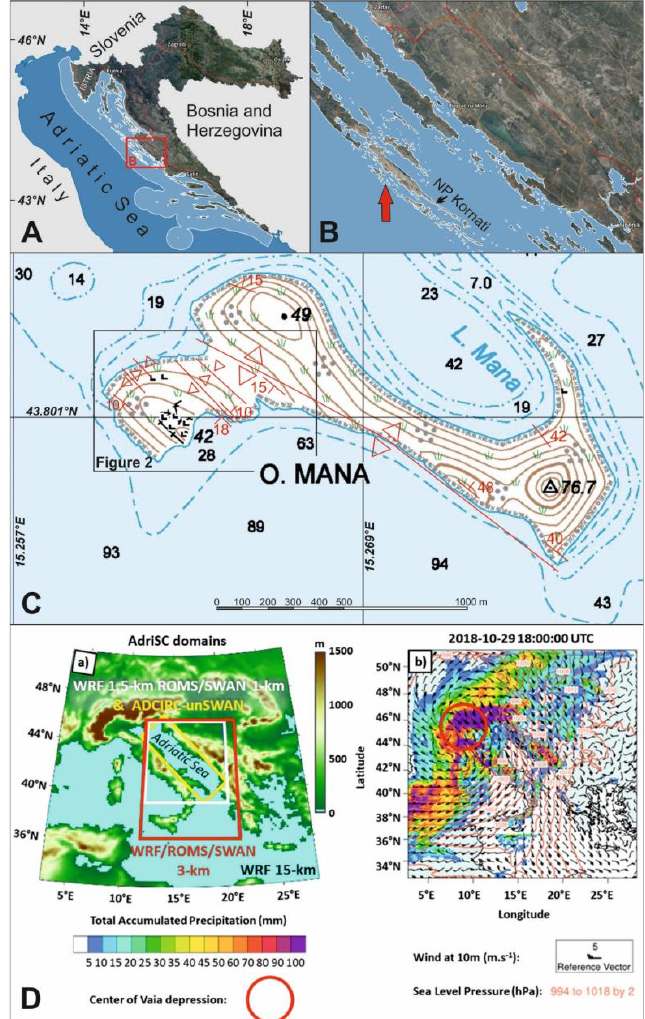
Figure 1. ( A ) Location map of Croatia and the NP Kornati in Northern Dalmatia. ( B ) Location map of the island of Mana in Northern Dalmatia. ( C ) Topographic map of the island of Mana showing morphology and general bathymetry (in meters, https://geoportal.dgu.hr/ accessed on 8 January 2022), and geological structures of the bedrock carbonates (in red: anticlines, synclines, bed strike, dip, and dip angle). ( D ) ( a ) Orography used in the AdriSC WRF 15-km model and geographical location of the nested WRF, ROMS, SWAN, ADCIRC, and unSWAN models. ( b ) Accumulated rain, sea-level pressure, and the winds during the peak of the Vaia storm using the numerical results obtained with the WRF-15km model from the AdriSC modeling suite. The abbreviations are described in Section